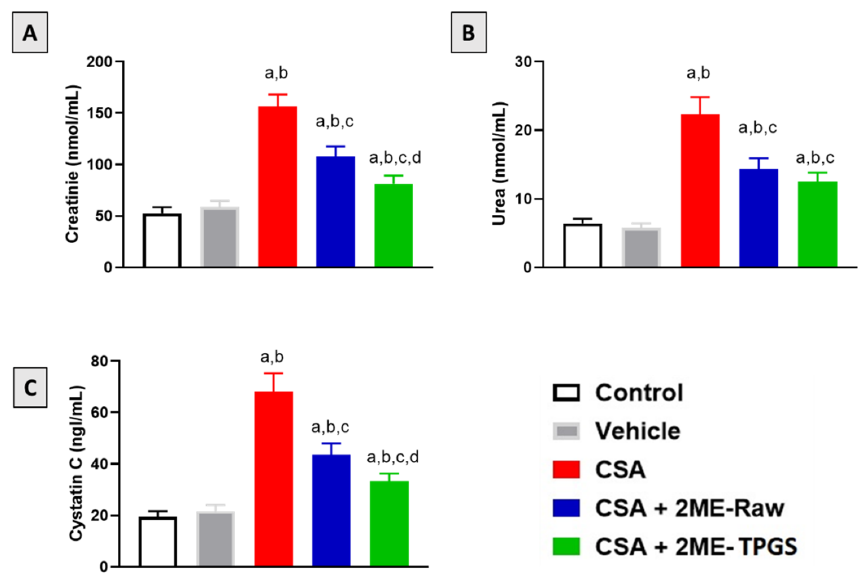
Figure 2. Effect of 2ME-TPGS micelles on serum markers of kidney function following cyclosporine A (CSA) challenge in rats. ( A ): creatinine, (B ): Urea, ( C ): Cystatin C. Data are presented as Mean ± SD ( n = 6). a: Significantly different from respective Control at p < 0.05; b: significantly different from